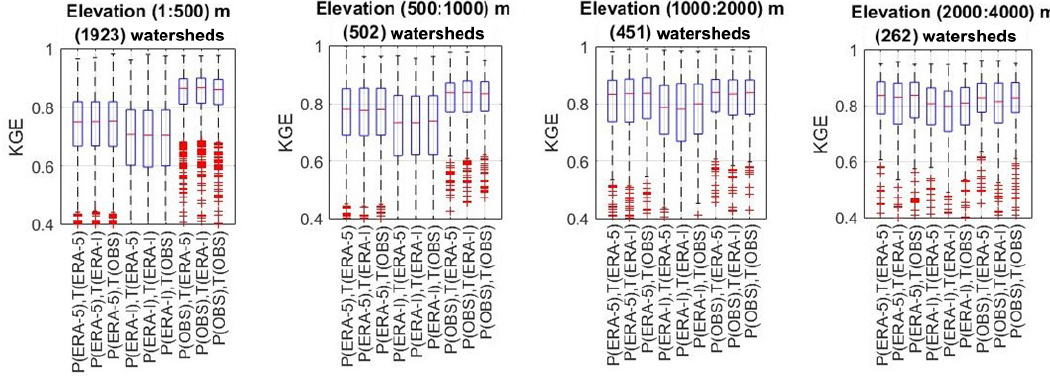
Results indicate that dataset performance and relative